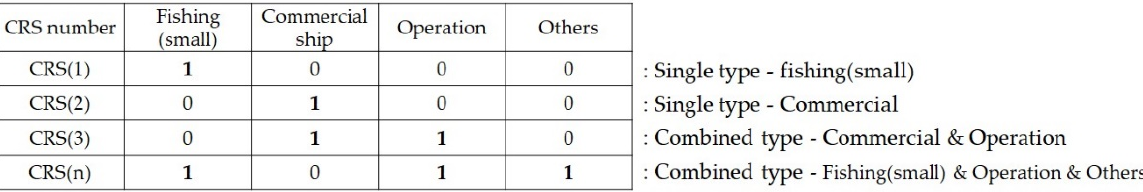
Figure 6. Schematic showing the feature extraction process of a “type of encounter” array. The sample situation was converted into relative bearing and distance in the Cartesian coordinate system. The quadrant changes were calculated and converted as a logical array(red box). 2.3.2. Feature Selection The primary purpose of feature selection was to select the distinctive features for effective clustering. Since features in the “area” and “ownship” classes were continuous numerical values, the Laplacian rank method was an appropriate feature selection method